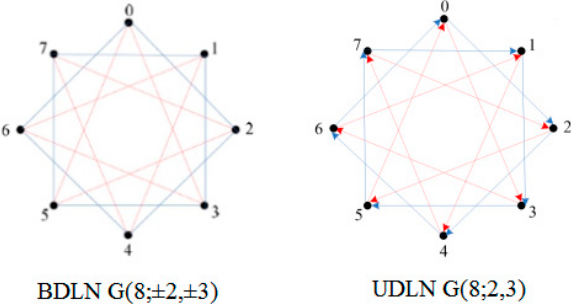
Figure 1. BDLN G(8; ± 2, ± 3) & UDLN Figure 1. BDLN G(8;±2,±3) & UDLN G(8;2,3).